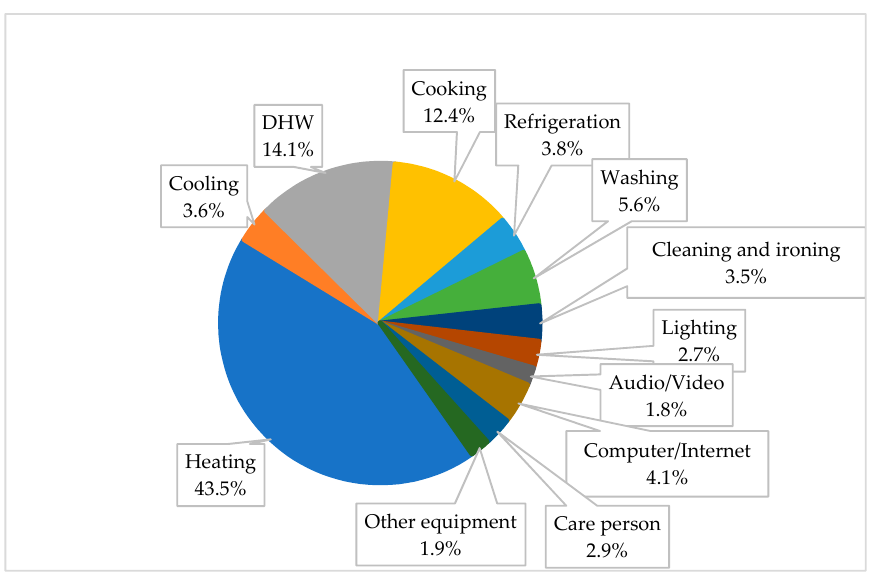
Figure 8. Average values of services share in dwellings energy consumption.